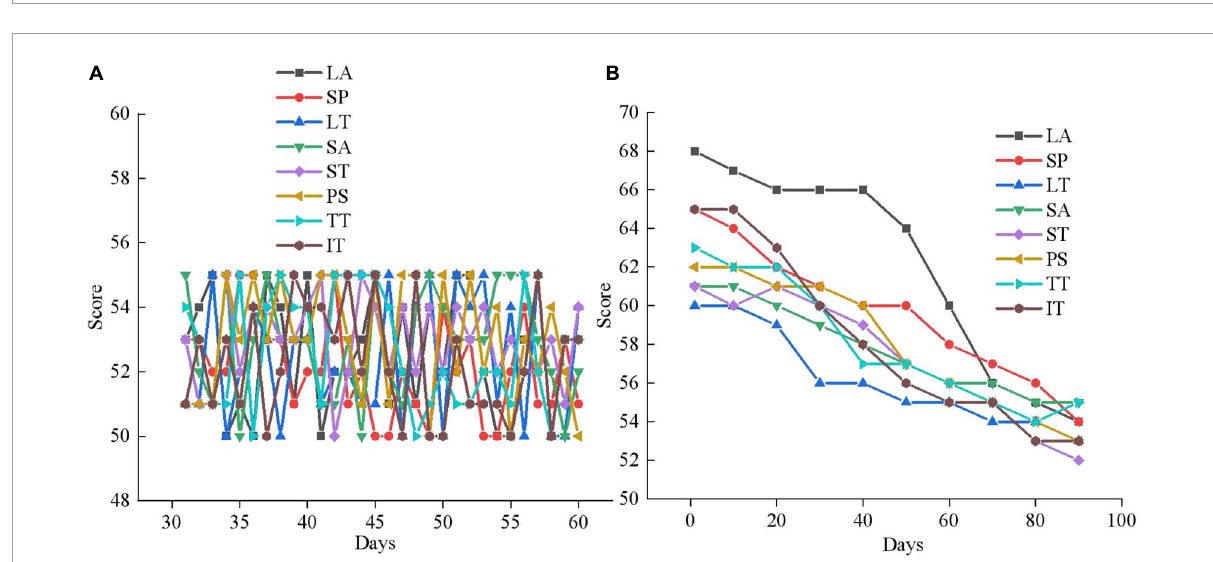
FIGURE13 Mental health outcomes of the experimental group in the second month of therapy. (A) Second month mental health assessment results; (B) the mental health changes of experimental group member 5.